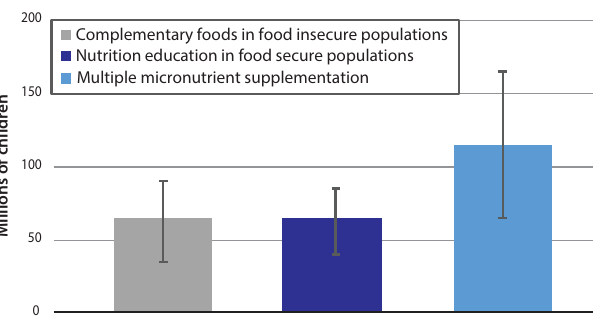
Fig. 3 Interventions required to offset 2015 El Niño. Millions of children who must be targeted with speci fi c interventions in order to reverse the effects on malnourishment caused by the 2015 El Niño. Effect sizes calculated using treatment effects in Bhutta et al. 37 . Bars represent the central estimate, with whiskers representing the 95% con fi dence interval of these estimates. See supplementary information for details of 36 – 59 months. With few exceptions, coef fi cients are consistent in sign and magnitude across age groups for each outcome variable and with the corresponding coef fi cient in Table 1.